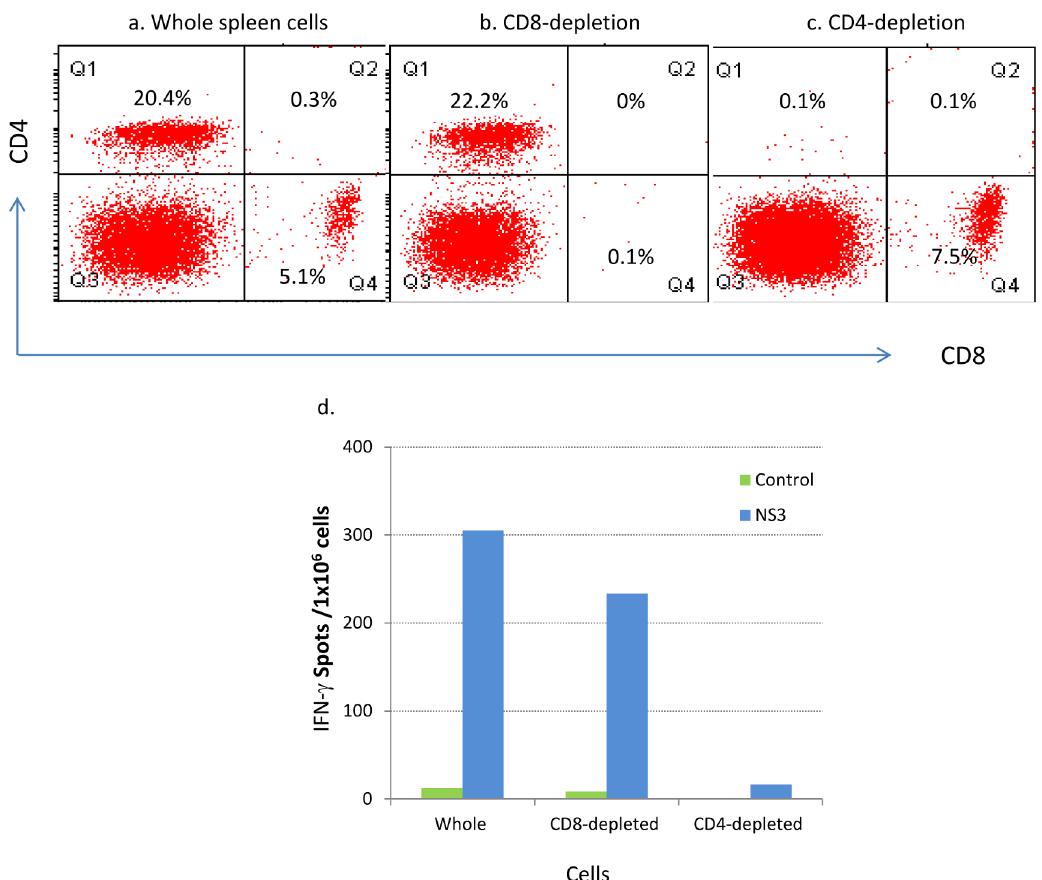
Fig 6. Depletion of CD4 and CD8 T cell subsets followed by IFN- γ ELISPOT. Whole spleen cells (a) or spleen cells depleted with either CD4 or CD8 subset (b, c), were stained with anti-mouse CD4 or CD8 monoclonal antibodies. The % of each subset is shown. IFN- γ response from whole or subset- depleted spleen cells was measured by ELISPOT assay (d). Results represent number of spots per million cells. Control = media without peptides.